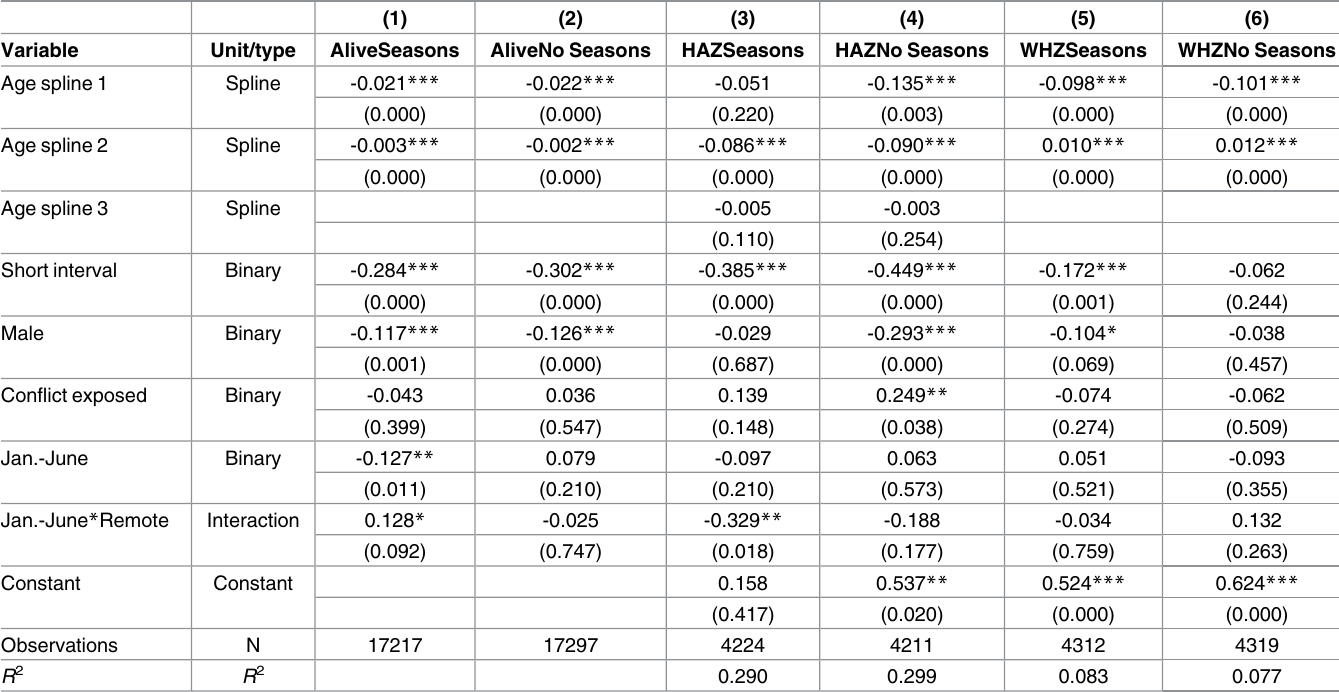
Table 6. Preferreddifference-in-differences results, splitting the sample by presenceof